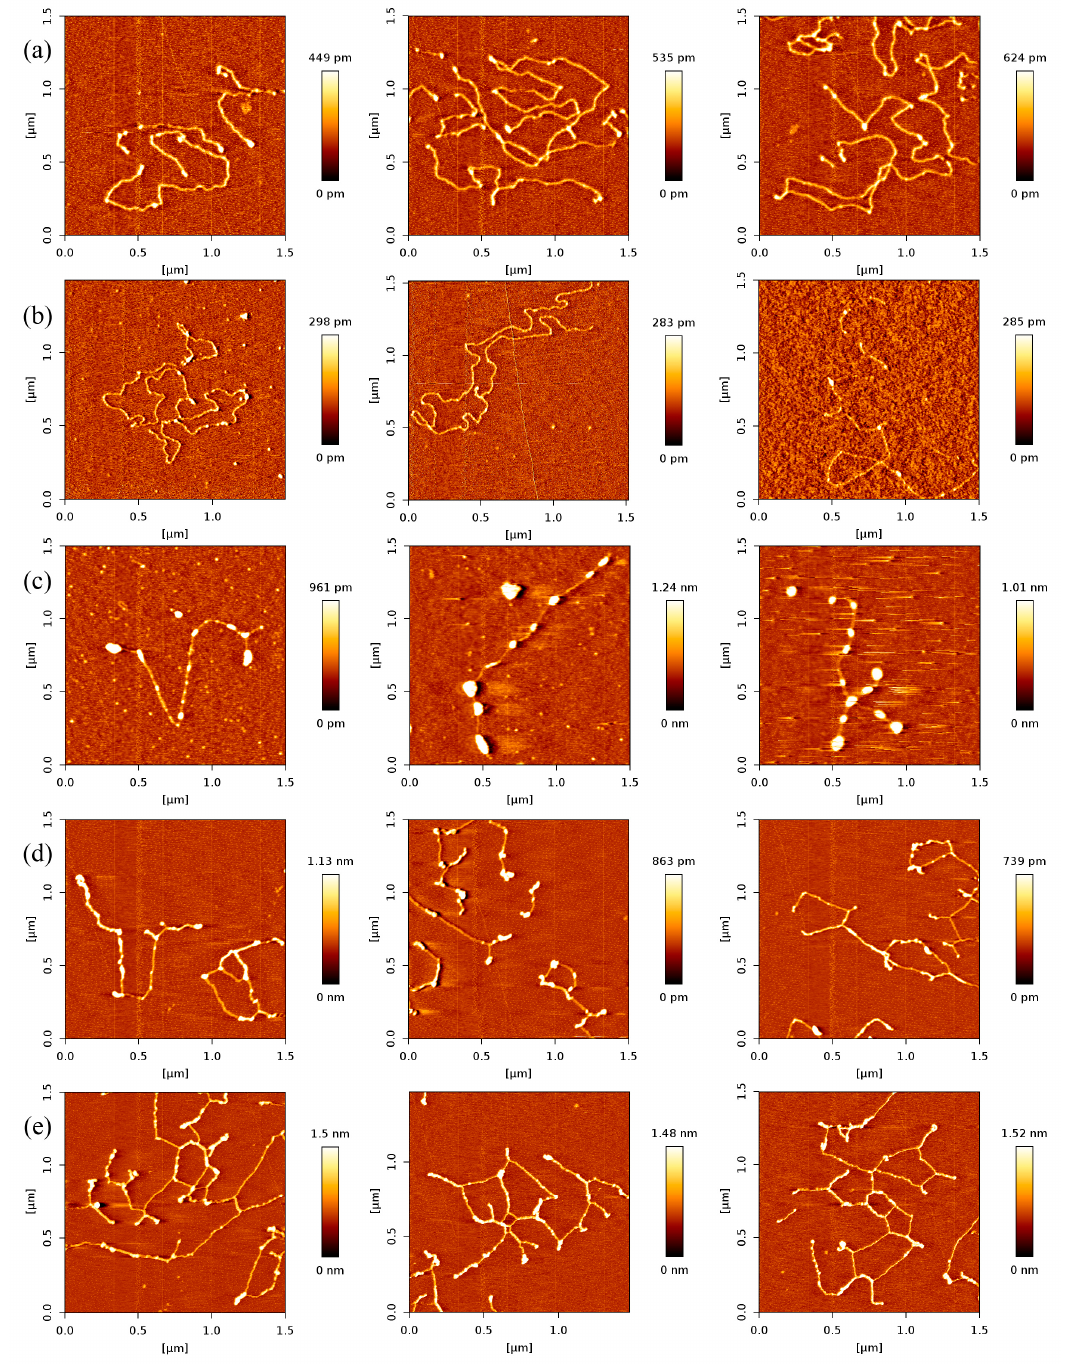
Figure 5. AFM images of p53 and 20,000 bp DNA, when the concentration ratio of p53 and DNA is 1:1 (height images, 1.5 µm × 1.5 µm). Meanwhile, the concentrations of p53 and DNA are 1 ng/µL and 1 ng/µL, respectively. The environment of the solution is 5 mM Hepes, pH 7.5 containing ( a ) 1 mM MgCl 2 ; (b) 3 mM MgCl 2 ; ( c ) 5mM MgCl 2 ; ( d ) 8 mM MgCl 2 ; ( e ) 10 mM MgCl 2 , respectively.